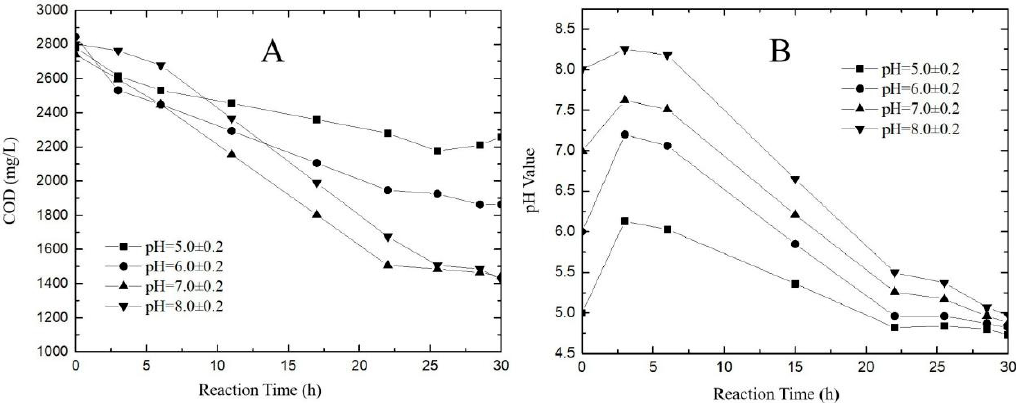
Figure 4. ( A ) Changes in COD under different initial pH values; ( B ) changes in pH under different initial pH values.